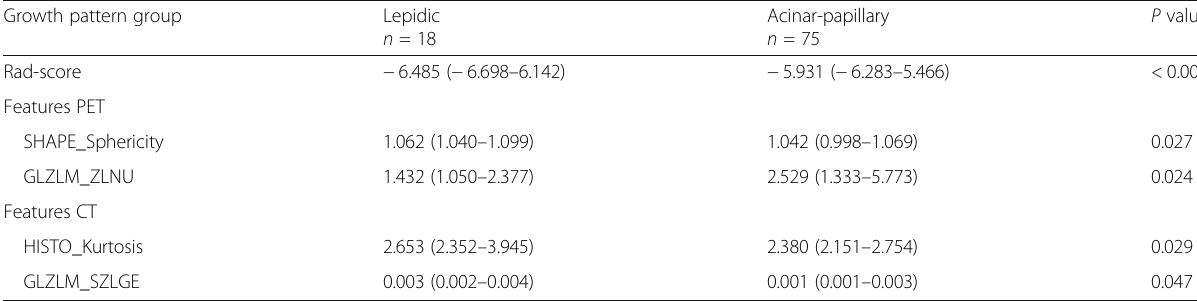
Table 2 Comparison of four radiomic features and rad-score between lepidic group and acinar-papillary group Growth pattern group